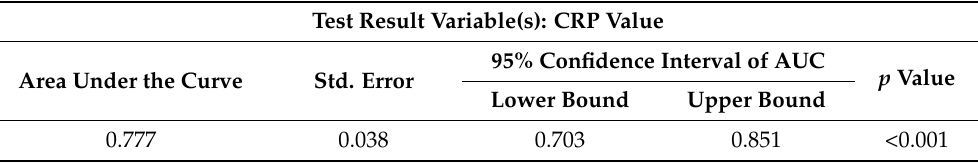
Table 7. Value of area under the curve for test variable CRP.